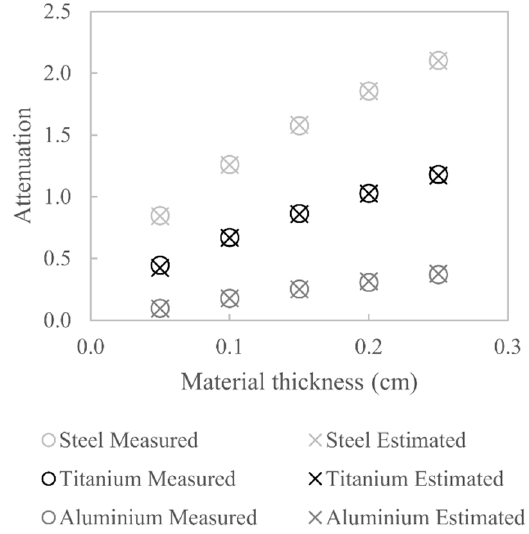
Figure 12. Comparison between measured and estimated X-ray attenuation for aluminium, titanium and steel.